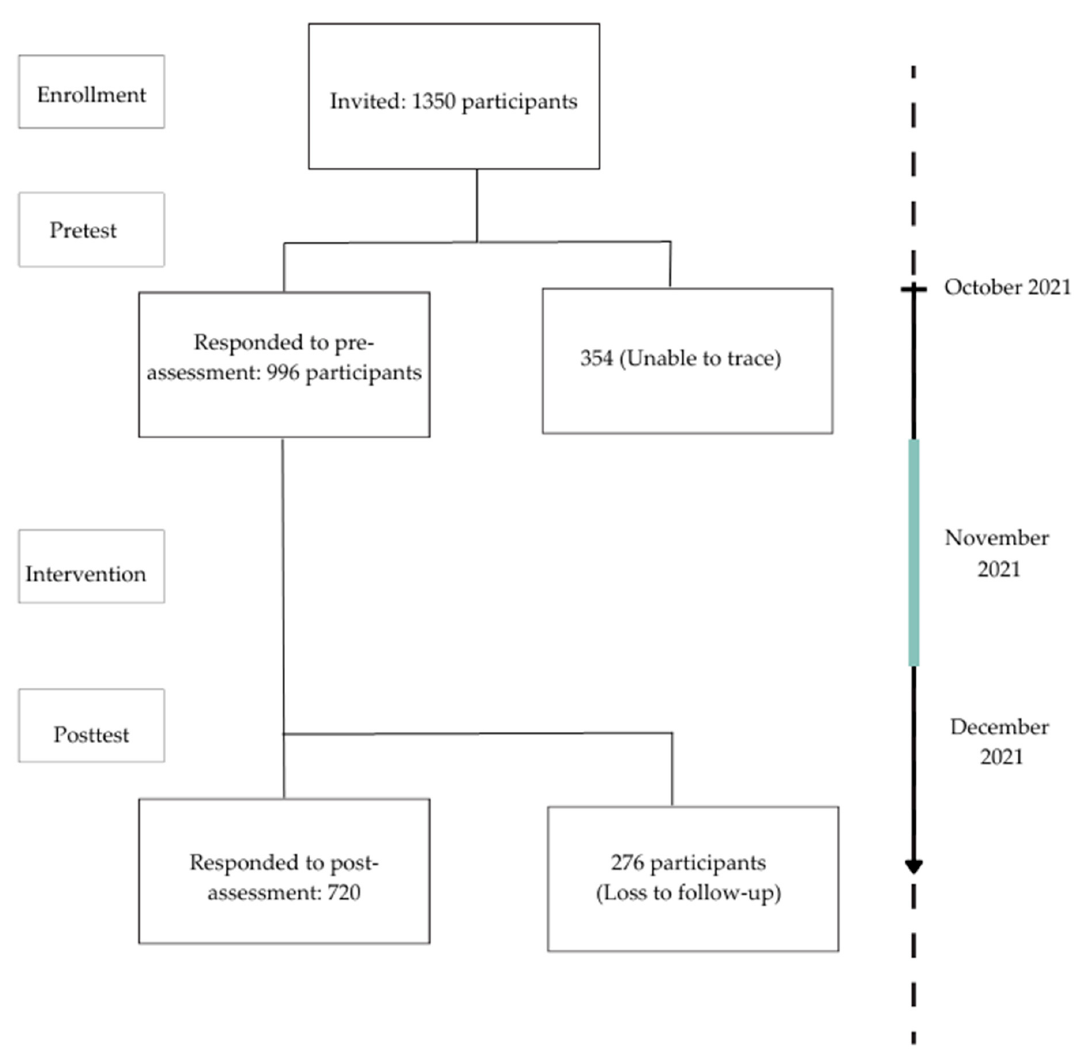
Figure 2. Flow diagram of the study participants in each stage. Table 3. Socio-demographic characteristics of the pre- and post-study